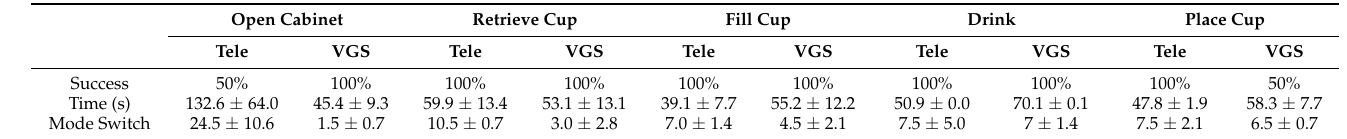
Table 7. Subtask success rate, time spent in seconds, and joystick mode-switch frequency for the case participant.